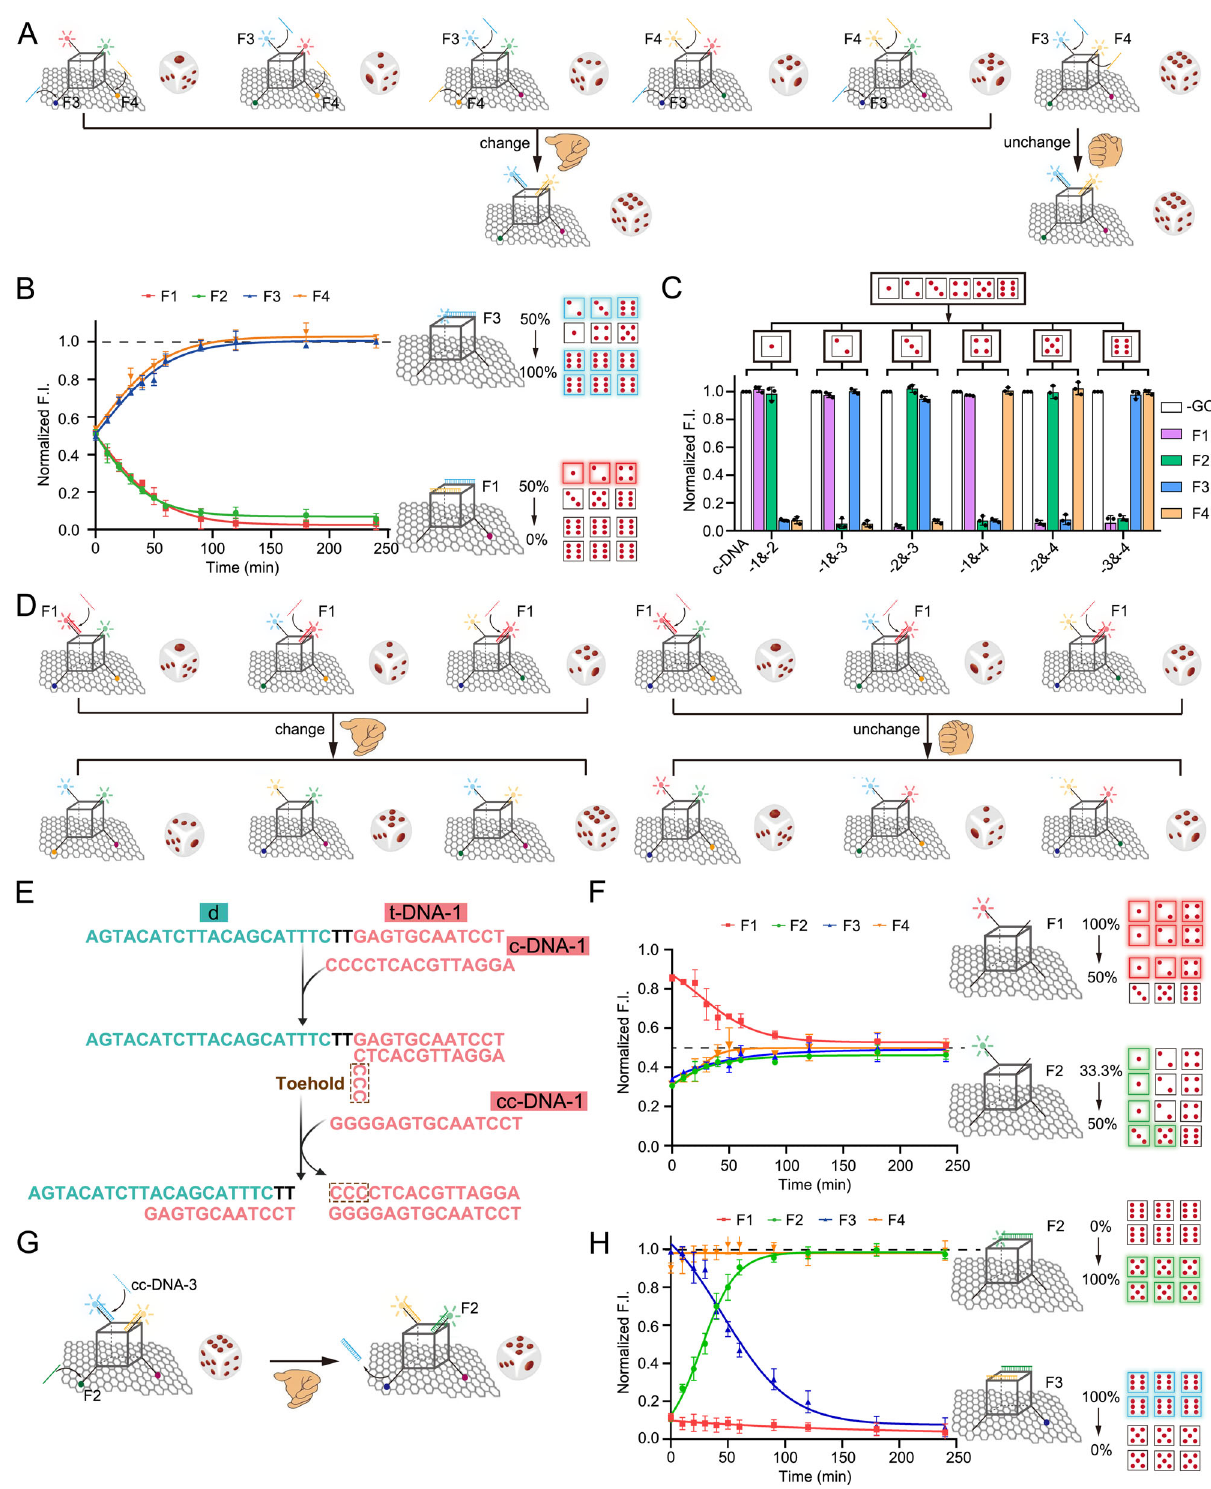
Fig. 6 | Arti fi cial manipulation of DNA nano-dice system by dual regulators. A Schematicillustration of c-DNA-3 and c-DNA-4 adding to DNAnano-dice system. B Kineticsoffoursignalschangeinducedbyaddingthec-DNA-3andc-DNA-4, n =3 independent experiments. Right, schematic illustration of theoretical changes in the pips and fl uorescence of dice. C Normalized fl uorescence intensity of four signals after adding two kinds of c-DNA at the same time, n =3 independent experiments. D Schematicillustrationofcc-DNA-1addingtoDNAnano-dciesystem withc-DNA-1. E SchematicillustrationofSDRamongt-DNA-1,c-DNA-1,andcc-DNA-